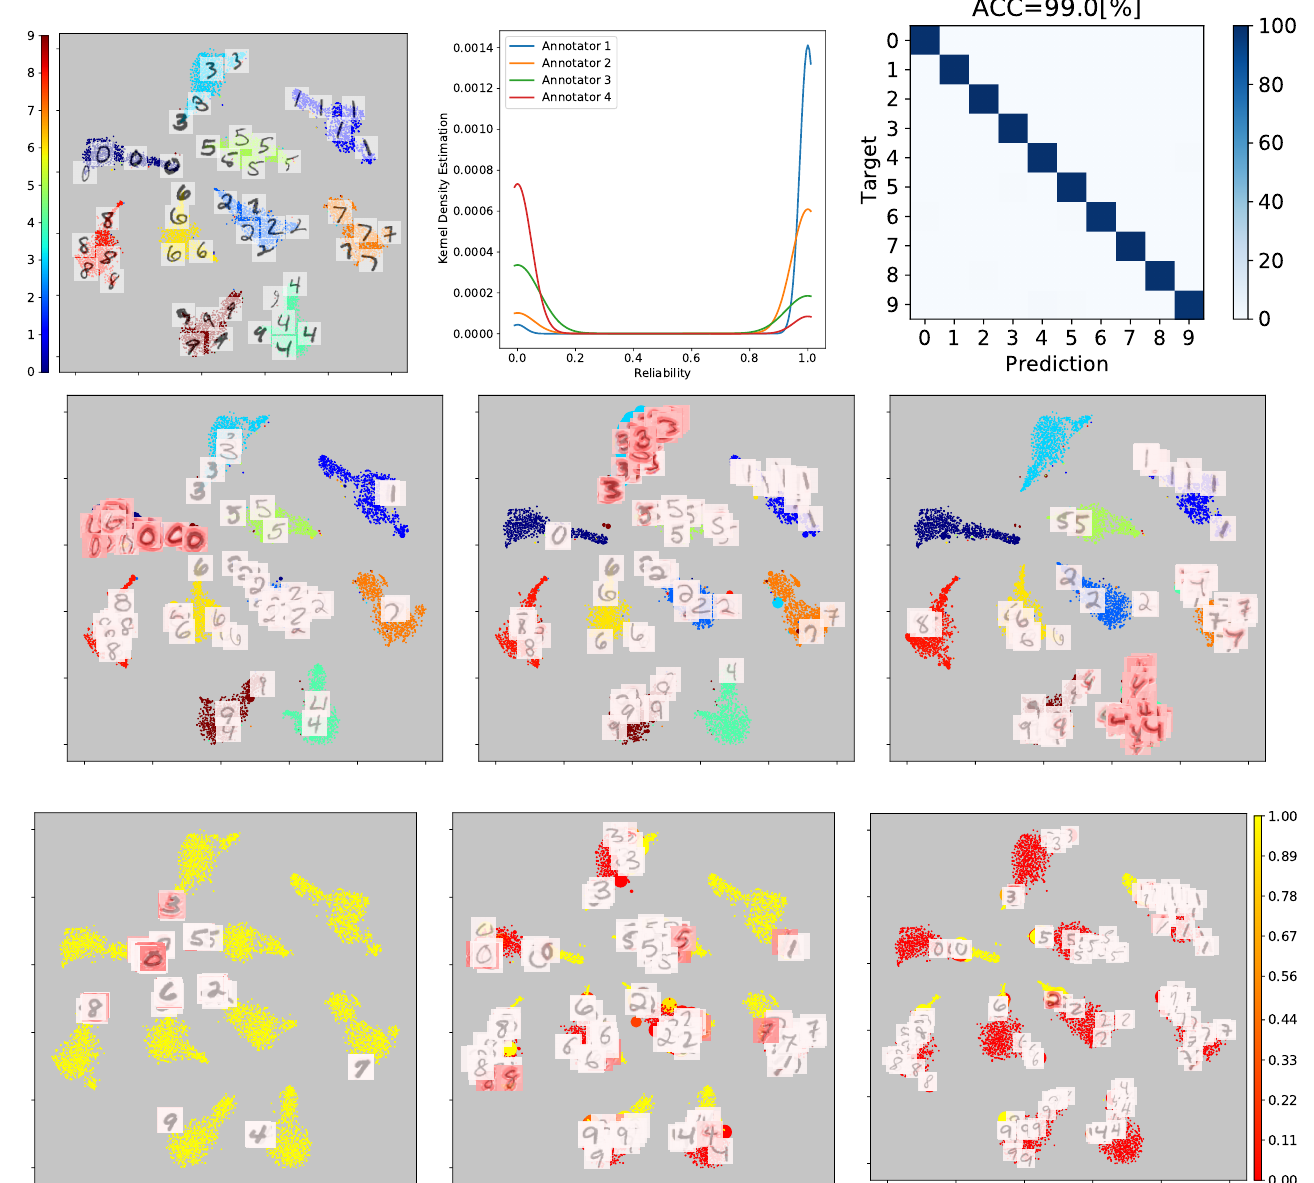
Figure 7. Visual inspection results for the MNIST database. A 2D t-SNE-based projection of the Mnist test set from the FC1 layer feature maps is shown (some exemplary images are depicted over their 2D projections, where numbers from zero to nine stand for each MNIST class). The ground truth labels are shown in color. The second row depicted the 2D projection of the ground truth prediction in color with some explanation maps for visualization purposes. The third row presents the 2D projection of each annotator’s reliability estimation in